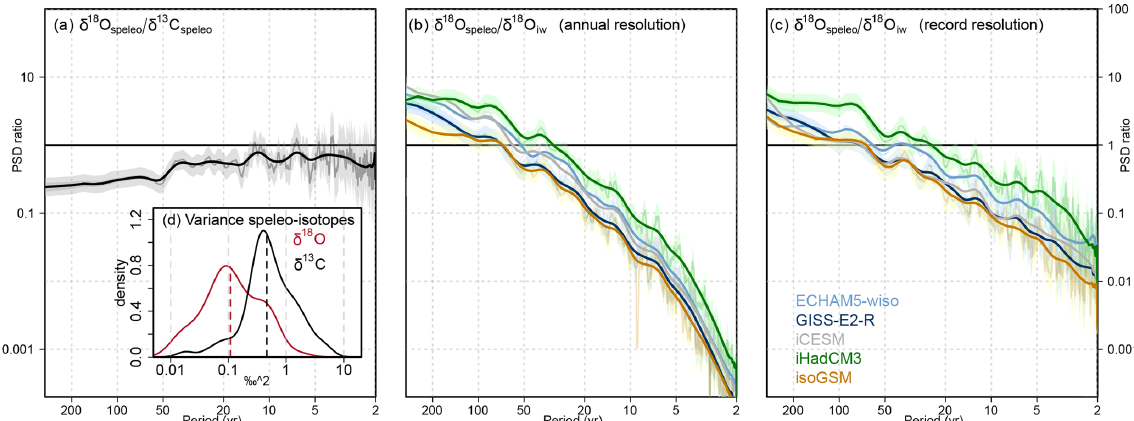
Figure 9. Spectral ratios of isotopes in speleothem and simulations on different timescales as shown by the ratios or mean power spectral densities (PSDs). (a) Spectral ratio between speleothem isotopes ( δ 18 O /δ 13 C). (b–c) Spectral ratio over all cave locations for δ 18 O speleo and δ 18 O iw per simulation (model colors). In (b) we show the spectral ratios of δ 18 O speleo to δ 18 O iw downsampled to the individual record resolution, and in (c) we show the ratios to δ 18 O iw at annual resolution. The full spectra are shown in faded colors, and a smoothed spectrum is shown in black or the model colors. (d) Variance of detrended δ 18 O speleo (red) and δ 13 C speleo (black) as measured in speleothem records. The dashed line indicates the median of the distribution.